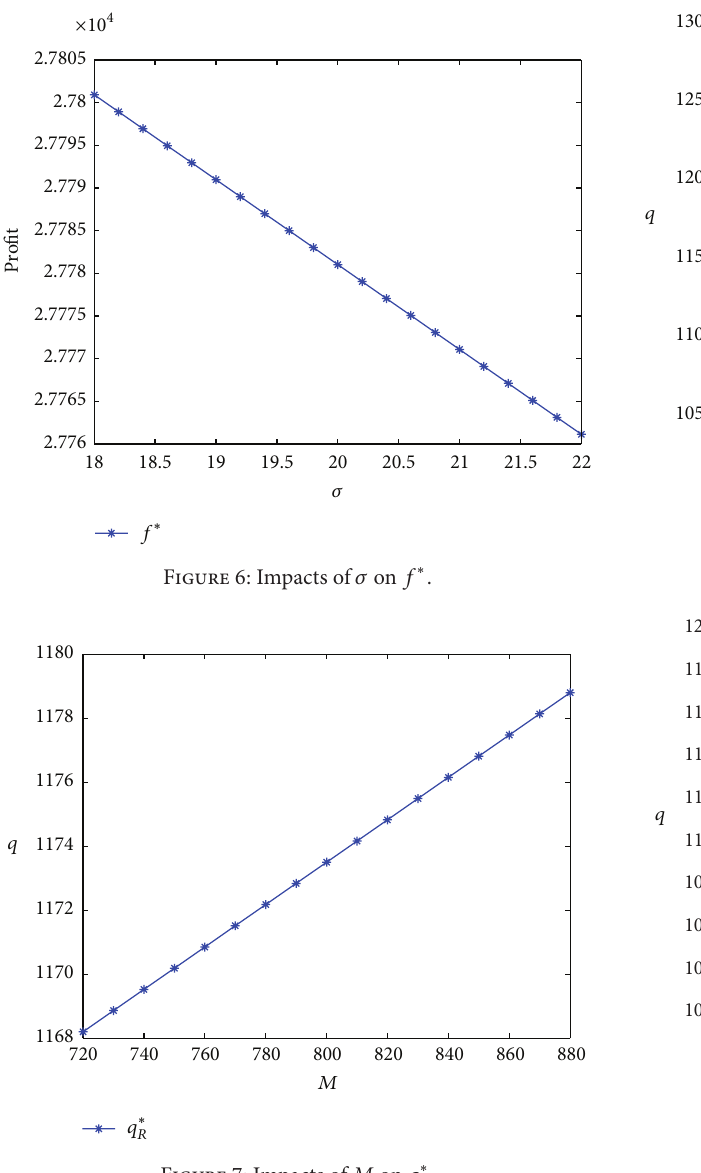
Figure 9: Impacts of 𝑇 on 𝑞 ∗ and 𝑞 ∗ 𝑅